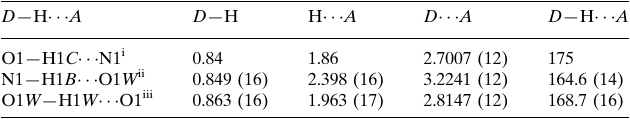
Hydrogen-bond geometry (A˚ , (cid:2)